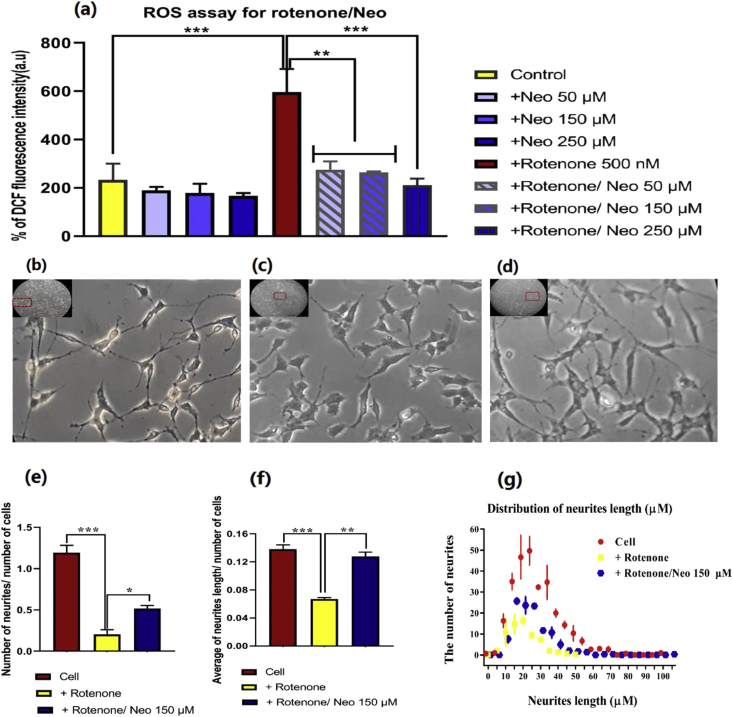
(a) The amount of ROS levels in SH-SY5Y cells treated with different concentrations of neobaicalein alone (50, 150, 250 μM) and in the presence of 500 nM rotenone detected by DCF fluorescence intensity. The morphology of differentiated SH-SY5Y cells and their neurites in (b) the cells with no treatment, (c) the cells treated with rotenone, and (d) the cells treated with rotenone/neobaicalein (inserts are the whole lens of the camera, and part of it is magnified). (e) The number of neurites, (f) the average of neurite length, and (g) the distribution of various neurite lengths were measured using image J. Scale bar, 100 μm. ∗P-value ≤ 0.05, ∗∗P-value ≤ 0.01, ∗∗∗P-value ≤ 0.001, (N = 3, Mean ± SD).